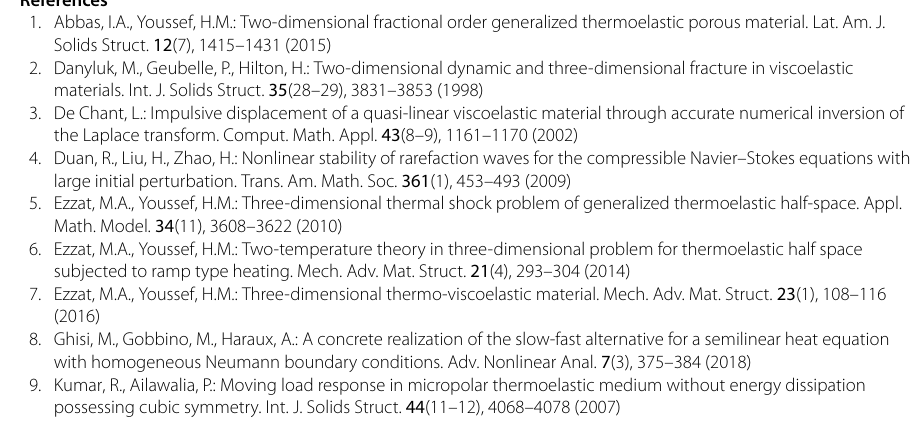
Acknowledgements Not